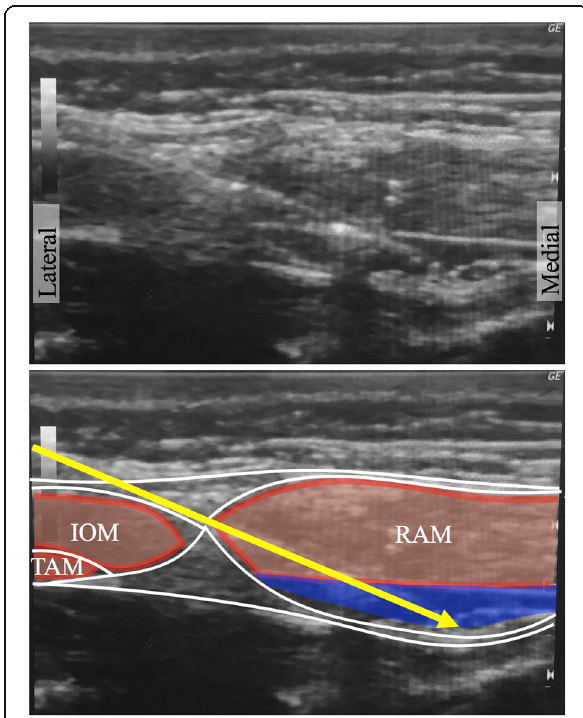
Fig. 1 The injection between the rectus muscle and the posterior sheath. The tip of the needle ( yellow arrow ) is on the posterior lobe of the rectus sheath. The deposition of injected local anesthetic ( blue semicircle ) is observed behind the rectus abdominis muscle. RAM rectus abdominis muscle, IOM internal oblique muscle, TAM transversus abdominis muscle